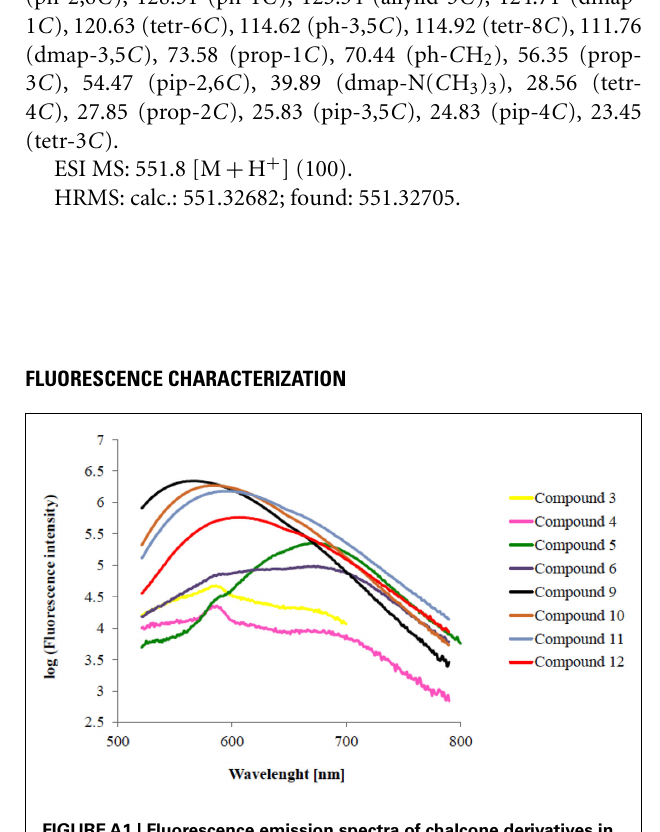
FIGUREA1 | Fluorescence emission spectra of chalcone derivatives in logarithmic delineation (Excitation wavelength: 405nm).